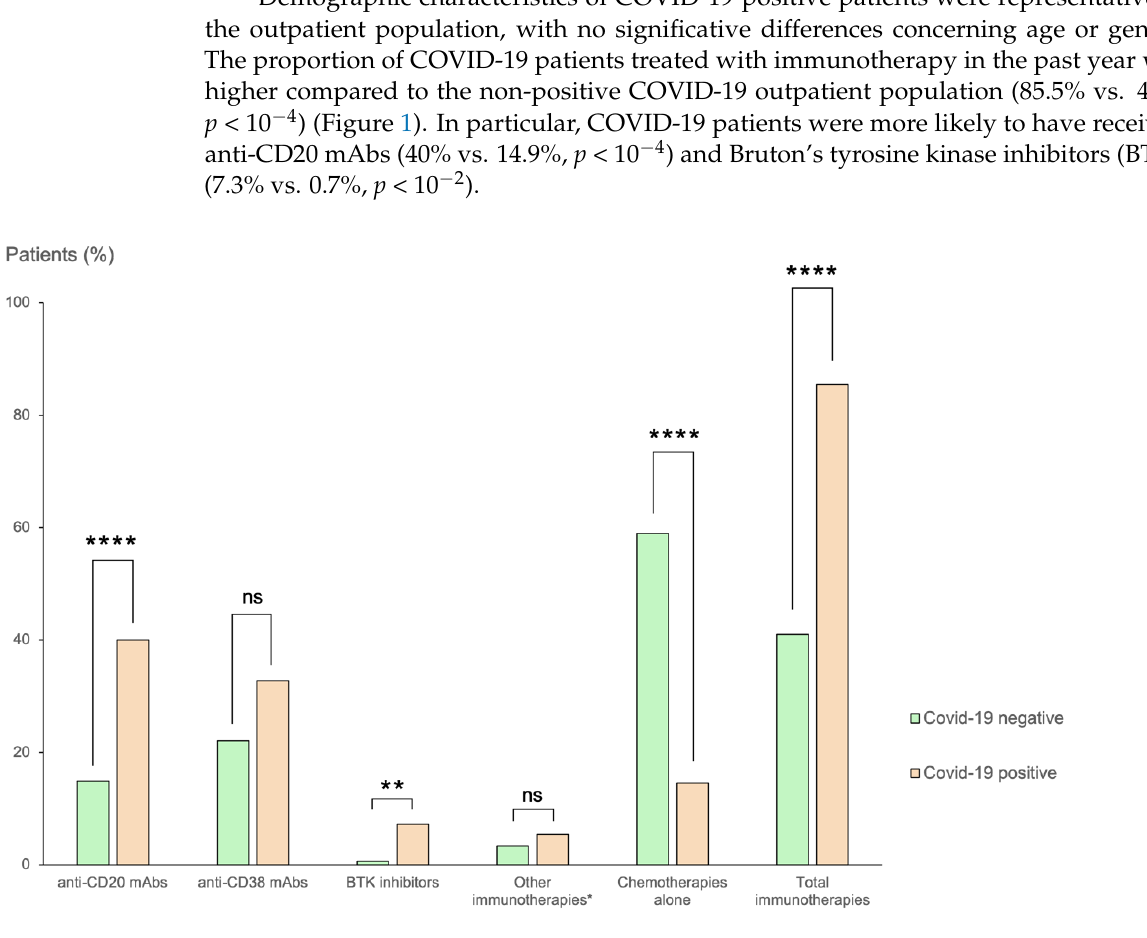
Figure 2. Distribution of hematological malignancies (%) in COVID-19-positive and non-positive patients. Abbreviations: MM, myeloma multiple; LG/CLL, low-grade lymphoma and chronic lym- phocytic leukemia; HL/HG NHL, Hodgkin's lymphoma and high-grade non-Hodgkin's lymphoma; MDS/AL, myelodysplastic syndrome and acute leukemia. (**, p < 10 − 2 ; ns, non-significant)